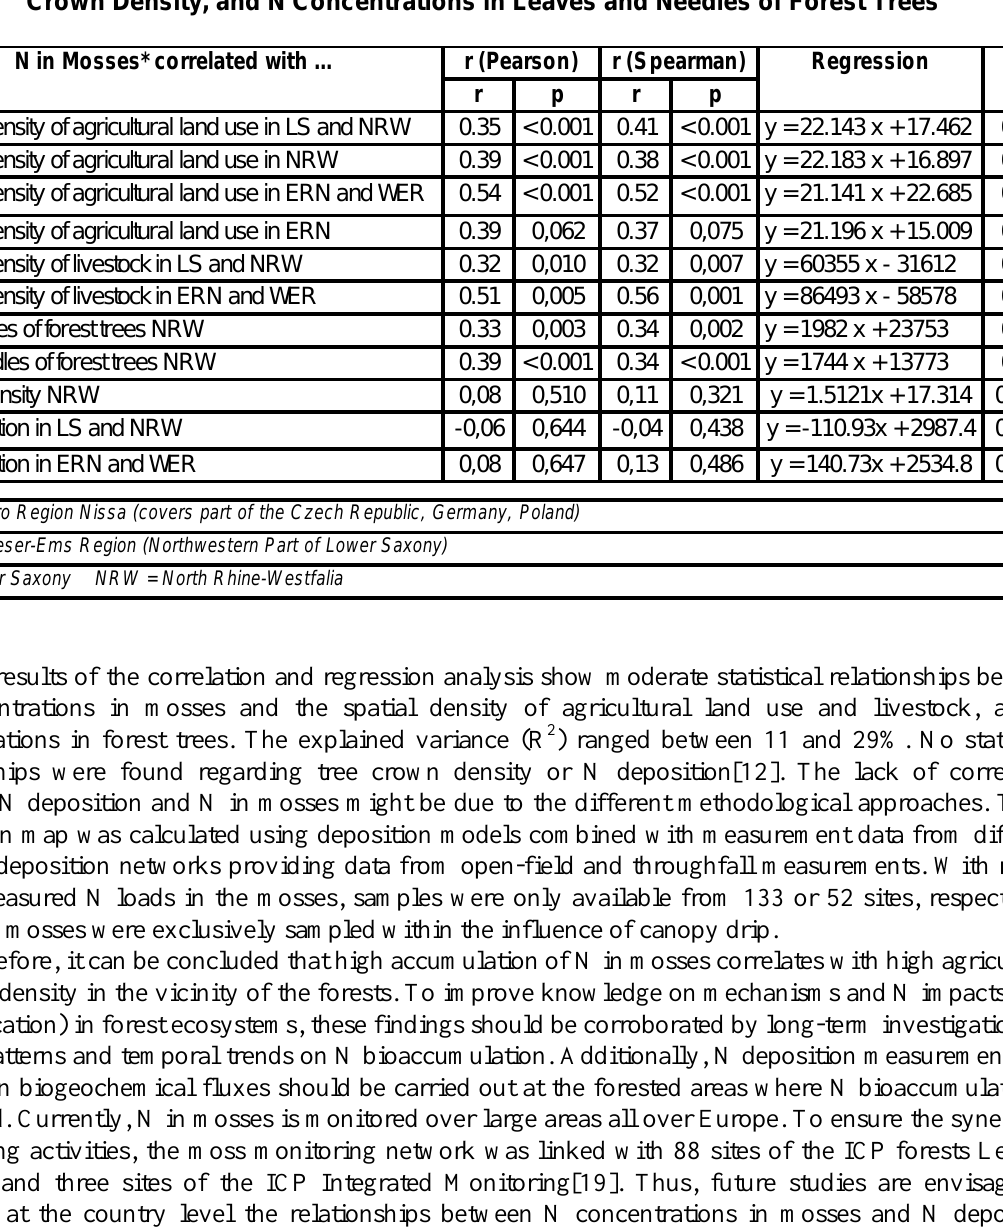
Statistical Relations Between N Accumulations in Mosses and Land Use, Modeled N Deposition, Crown Density, and N Concentrations in Leaves and Needles of Forest Trees